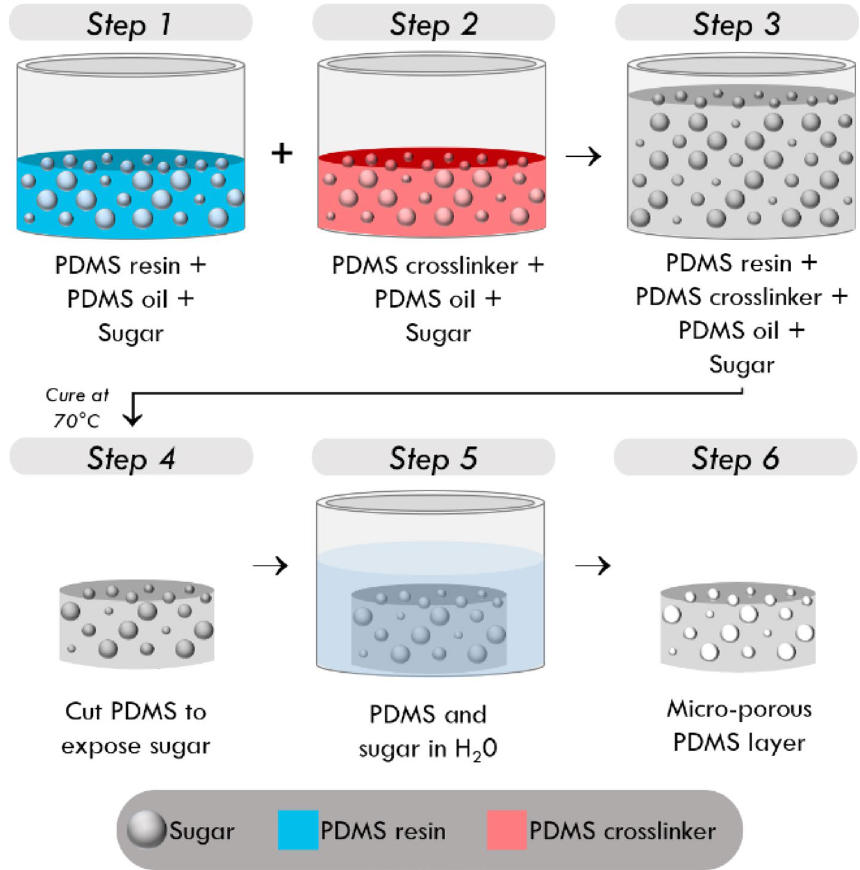
Figure 1. Fabrication process of micro-porous silicone layers by sacrificial templating of sugar